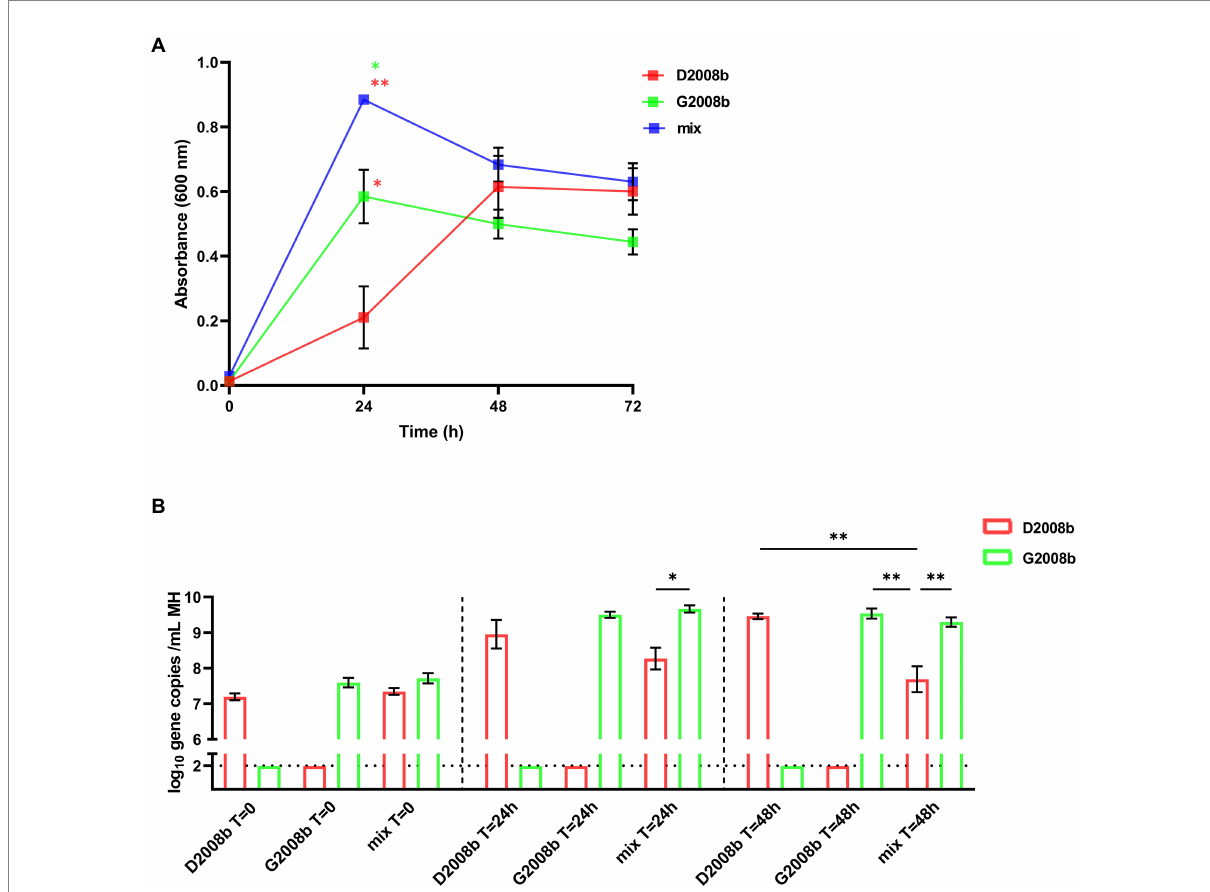
FIGURE 7 In vitro co-culture of both Campylobacter jejuni strains in MH broth. Both C. jejuni strains were grown separately and together in MH broth and absorbances at 600 nm were measured at different time points (A) . To evaluate the amounts of each strain, strain specific qPCRs were performed from C. jejuni pellets (B) . Vertical bars represent mean values ± SEM, and horizontal dotted lines denote the threshold (2 log 10 gene copies/mL of MH broth). Student t tests were used to analyze statistical differences of absorbance and ANOVA test followed by Tukey’s multiple comparison tests to compare qPCR results by time point between conditions. Co-culture assays were conducted in three independent replicates. * and ** indicate p <0.05 and p <0.01